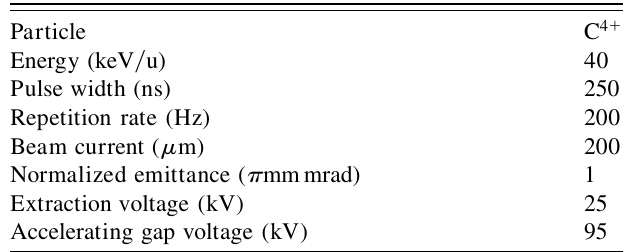
TABLE II. ECR ion source